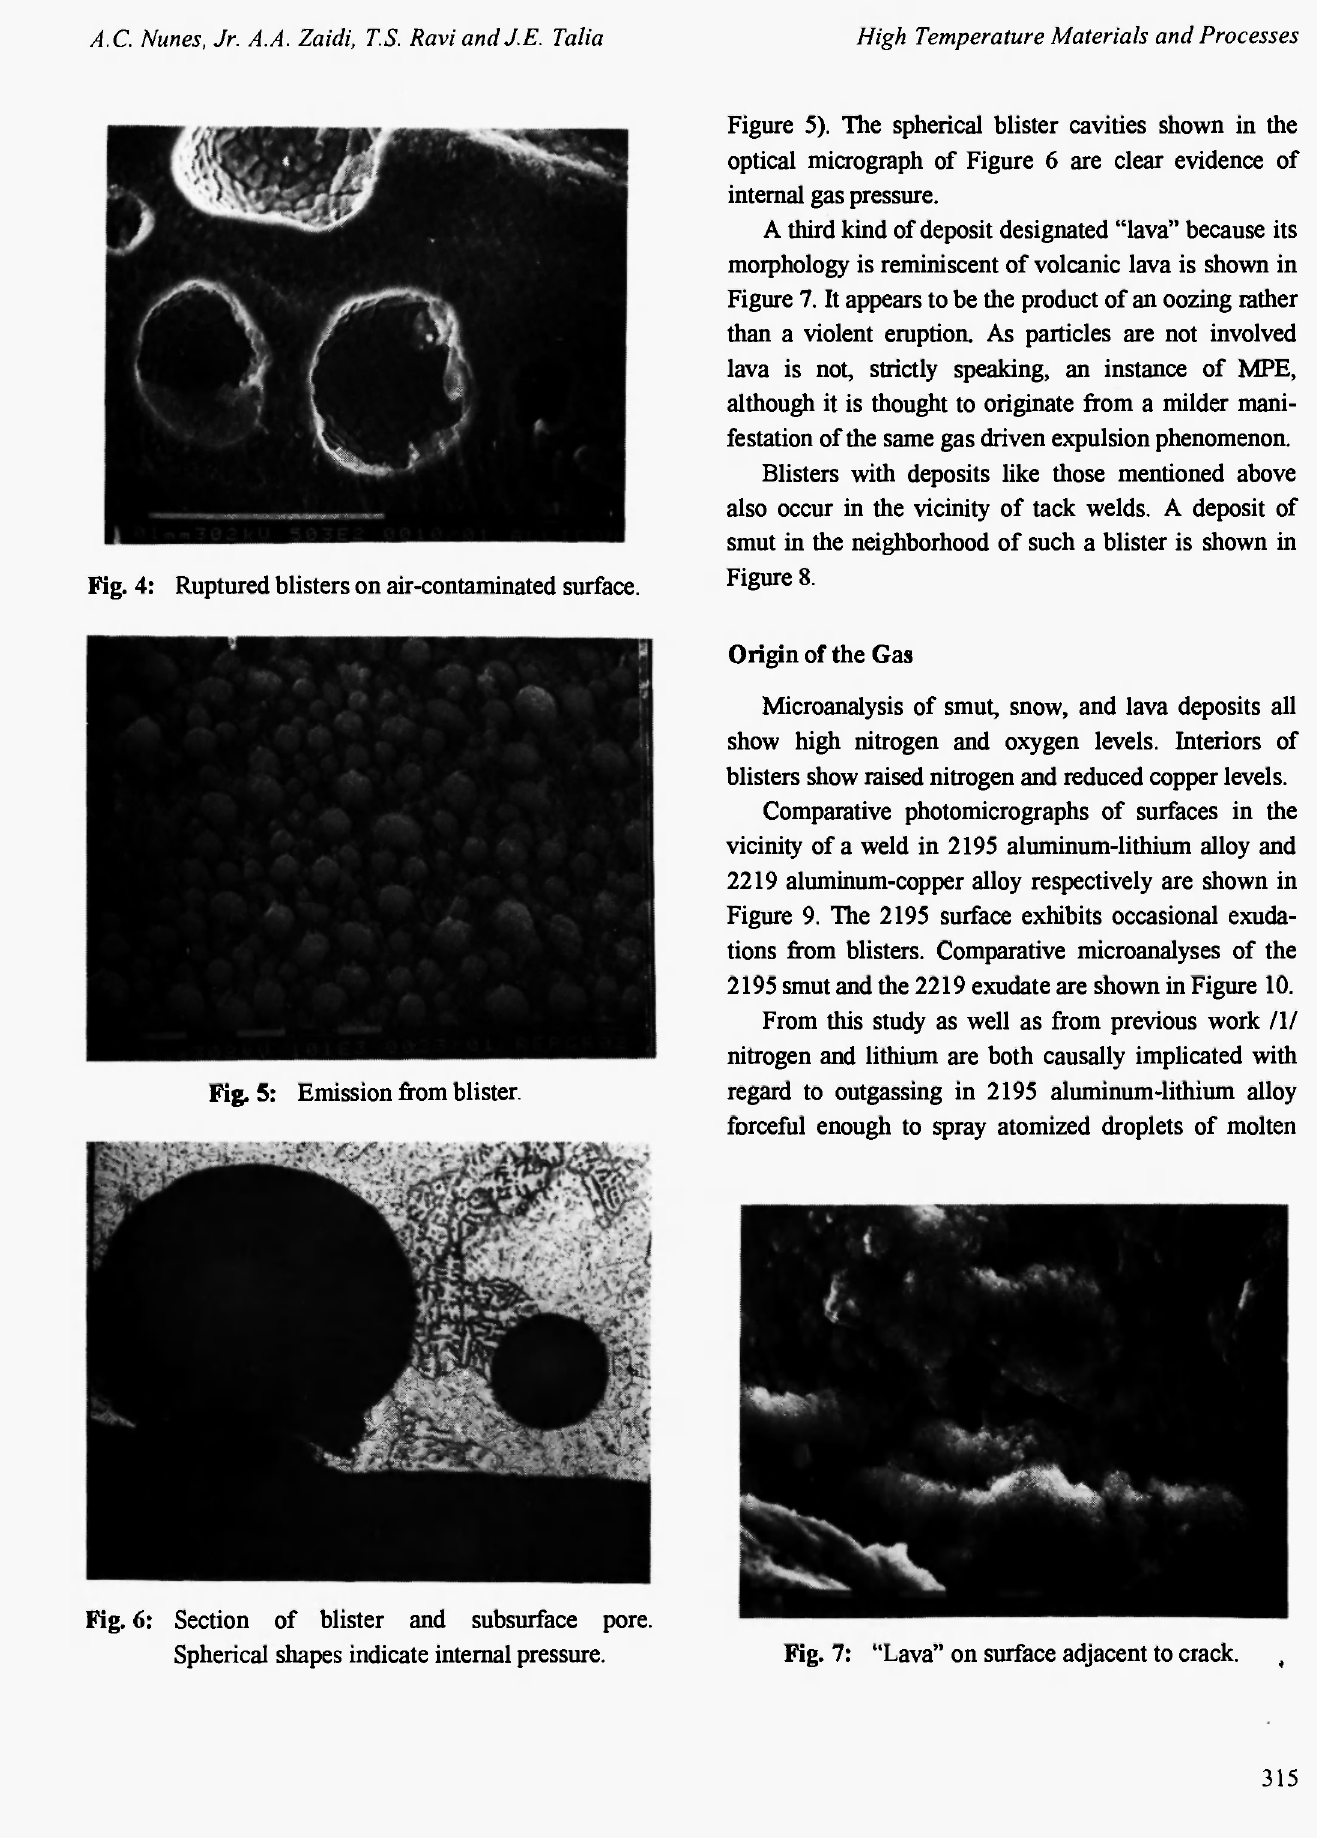
Fig. 6: Section of blister and subsurface pore. Spherical shapes indicate internal pressure. Fig. 7: "Lava" on surface adjacent to